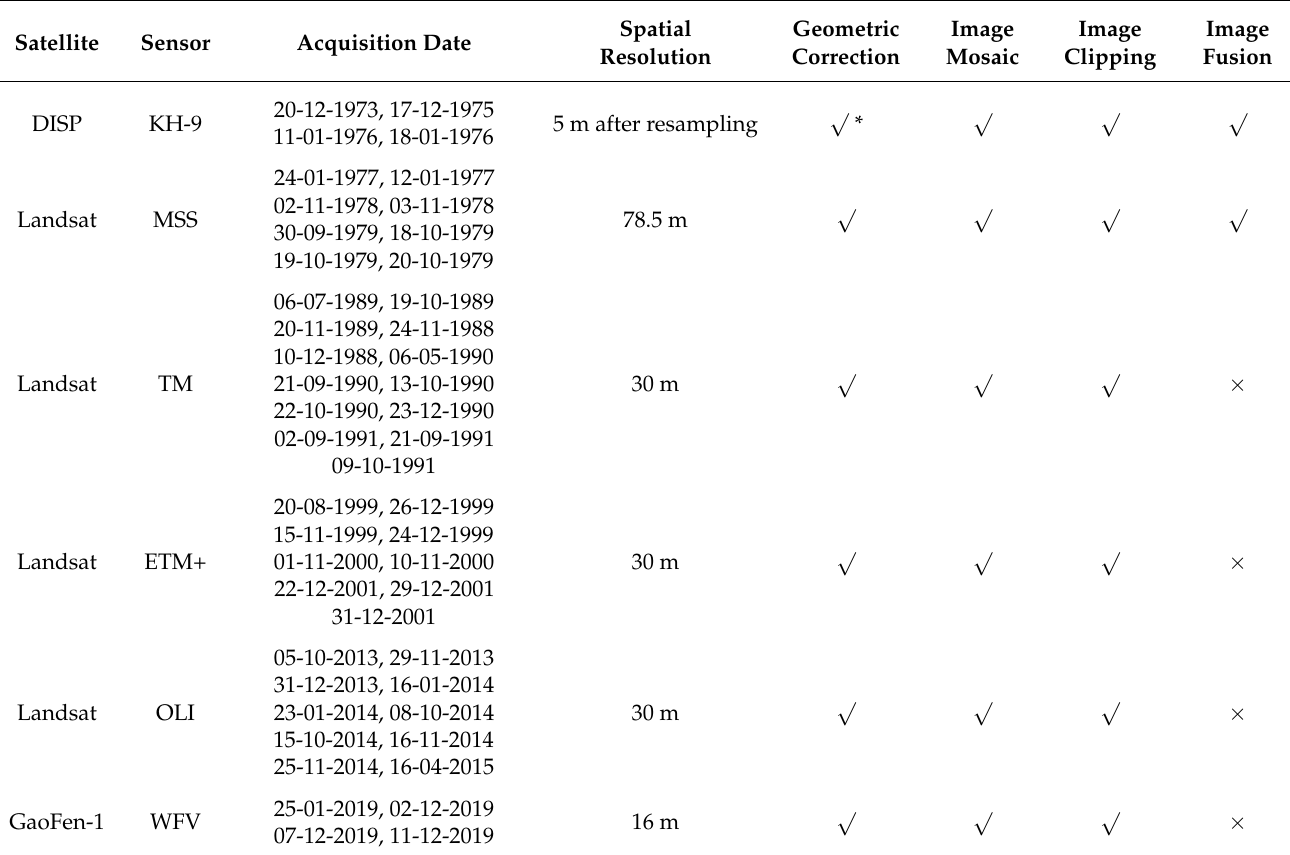
Table 1. Summary of remote sensing data used and pre-processing steps taken in this